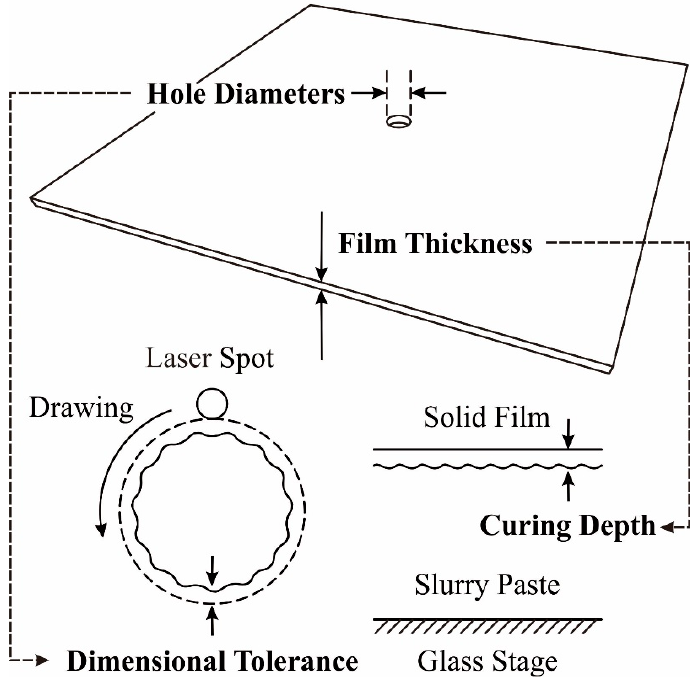
Figure 1. Schematic illustration of stereolithographic additive manufacturing (STL-AM). Cross-sec- tional layers are formed on paste materials by laser scanning. Solid objects are fabricated via layer laminating and interlayer bonding.